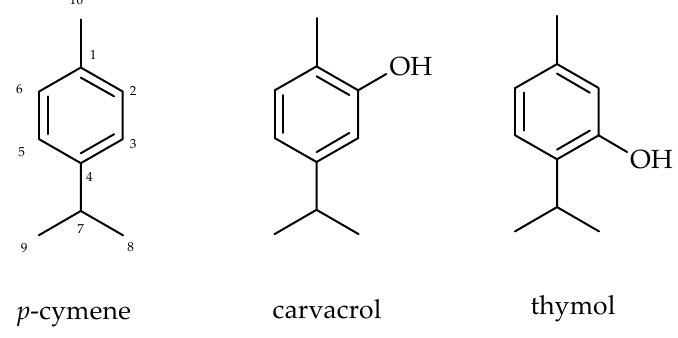
Figure 1. Structure of monoterpenes p -cymene, carvacrol and thymol.